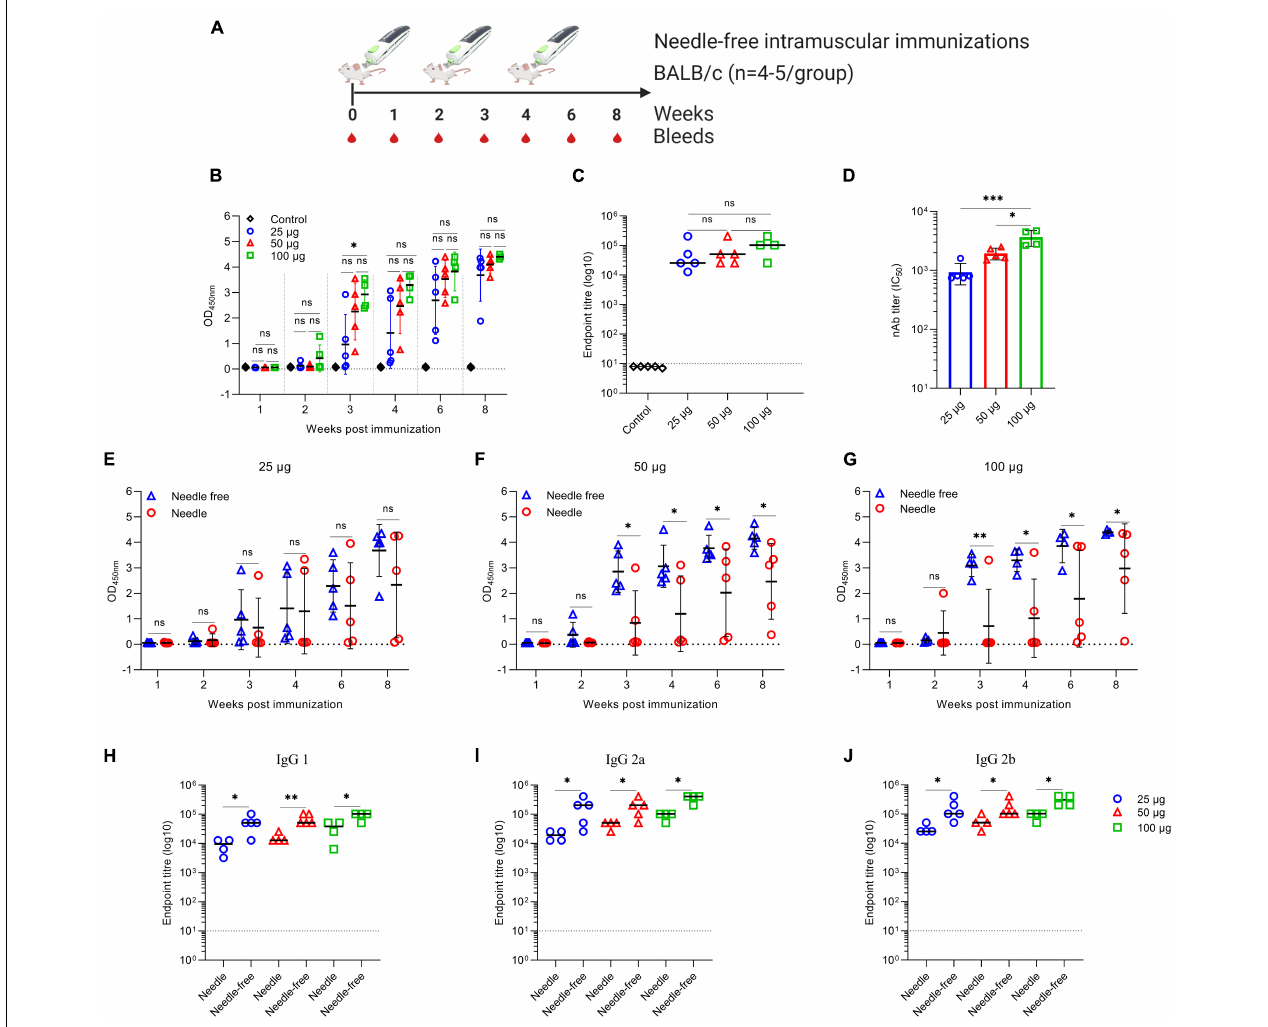
FIGURE 5 | Antigen-specific antibody response in BALB/c mice intramuscularly immunized with VIU-1005 using either needle-based or needle-free immunization. (A) Timeline of bleeding and immunization regimen. BALB/c mice were immunized intramuscularly with 3 doses of 25, 50, or 100 µ g at 2-week intervals using the VIU-1005 vaccine or control plasmid. (B) OD values of S1-specific binding total IgG at a 1:100 dilution from each mouse were determined by ELISA at 1, 2, 3, 4, 6, and 8 weeks post first immunization on day 0. (C) The end-point titer of S1-specific total IgG was determined by ELISA in samples collected from immunized mice at week 8. (D) nAb titers (IC 50 ) from mice immunized with doses of 25, 50, or 100 µ g of VIU-1005 plasmid using a needle-free system were determined at week 8. (E–G) OD values of binding total S1-specific IgG at a 1:100 dilution from 1, 2, 3, 4, 6, and 8 weeks post-first immunization on day 0 in groups immunized with 3 doses of (E) 25 µ g, (F) 50 µ g, or (G) 100 µ g of VIU-1005 plasmid at 2-week intervals using either needle injection or a needle-free Tropis system. (H–J) End-point titers of S1-specific (H) IgG1, (I) IgG2a, and (J) IgG2b were determined by ELISA in samples collected on week 8 from immunized mice. Data are shown as